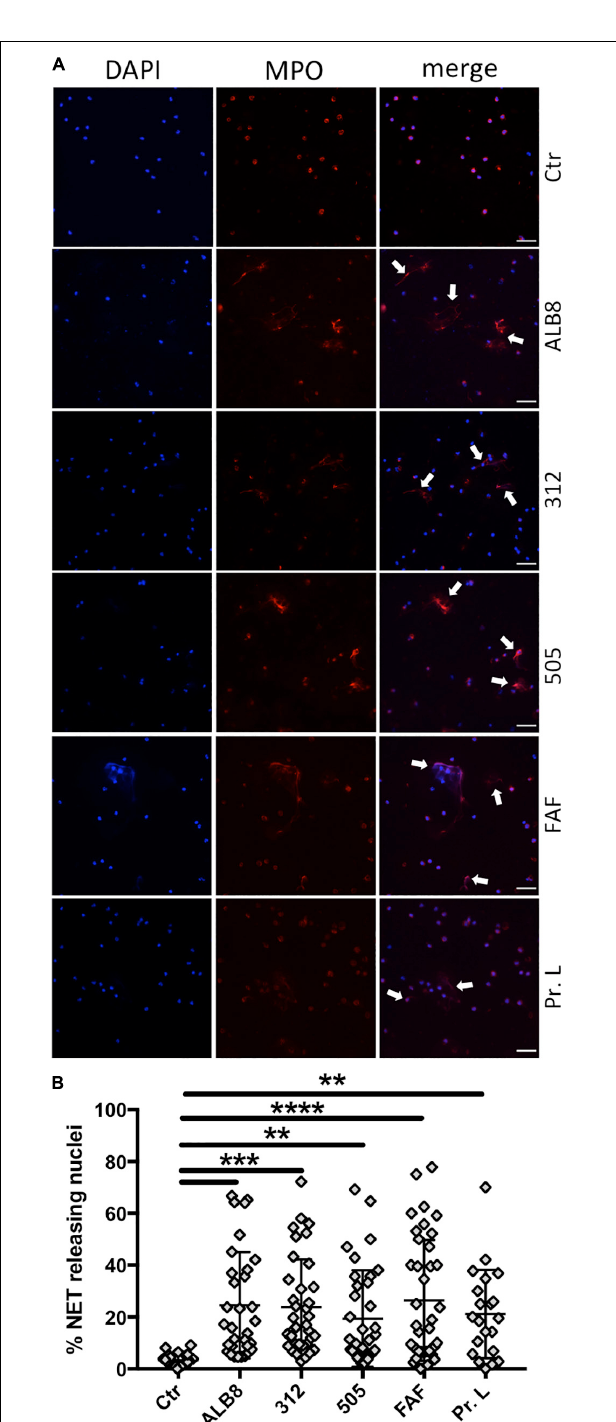
FIGURE 2 | F. magna bacteria and proteins induce NET formation. (A) Neutrophils were incubated with heat inactivated F. magna strains ALB8, 312 or 505 or with purified proteins FAF and L. Control (Ctr) represents unstimulated neutrophils. NETs (white arrows) were visualized with DAPI (blue) and MPO (red), scale bar is 50 µ m. (B) NET-releasing nuclei were quantified using ImageJ software and are displayed as percentage. Data represent mean ± SEM of 4 independent experiments. ** p ≤ 0.01, *** p ≤ 0.001, **** p ≤